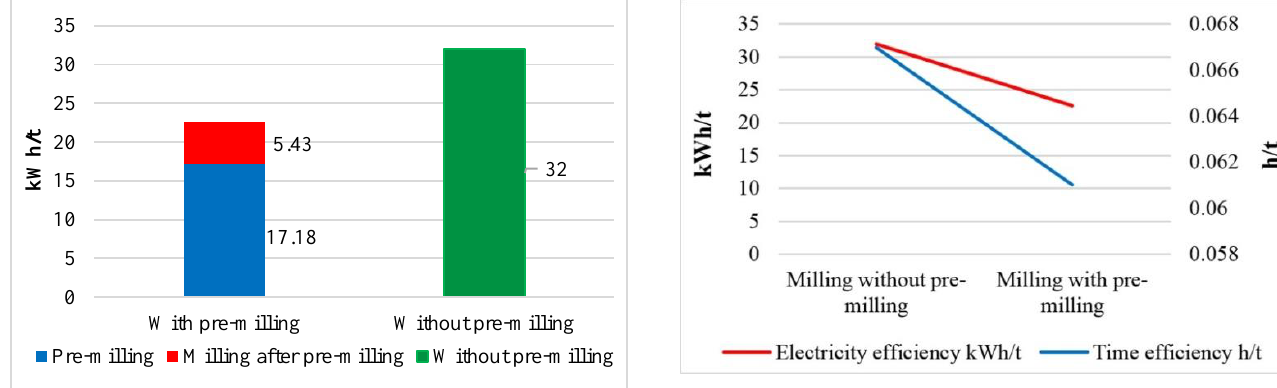
Fig. 7. Specific electricity consumption by milling mode.